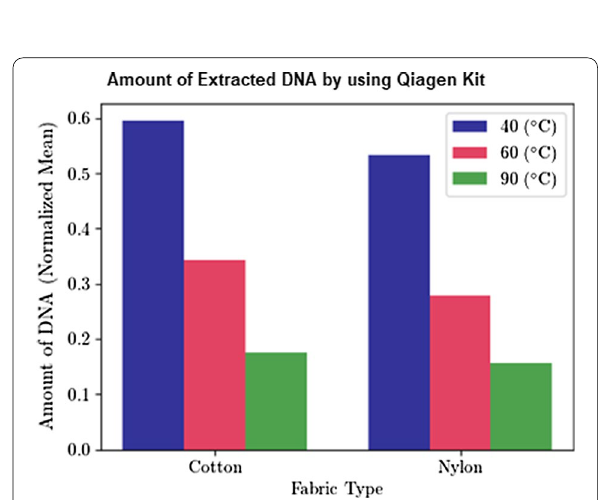
Fig. 11 Graphical representation of the amount of extracted DNA by using spin colon-based extraction